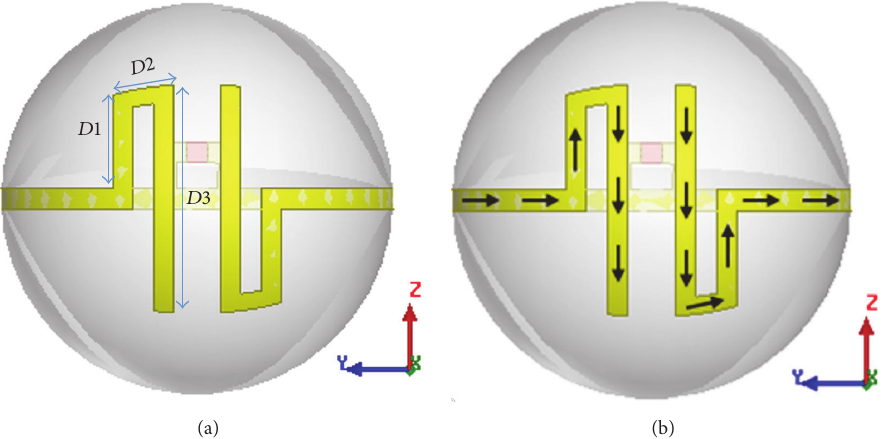
Figure 18: (a) Structure of the 3D spherical antenna with meander line and (b) current direction along the meander line dipole.